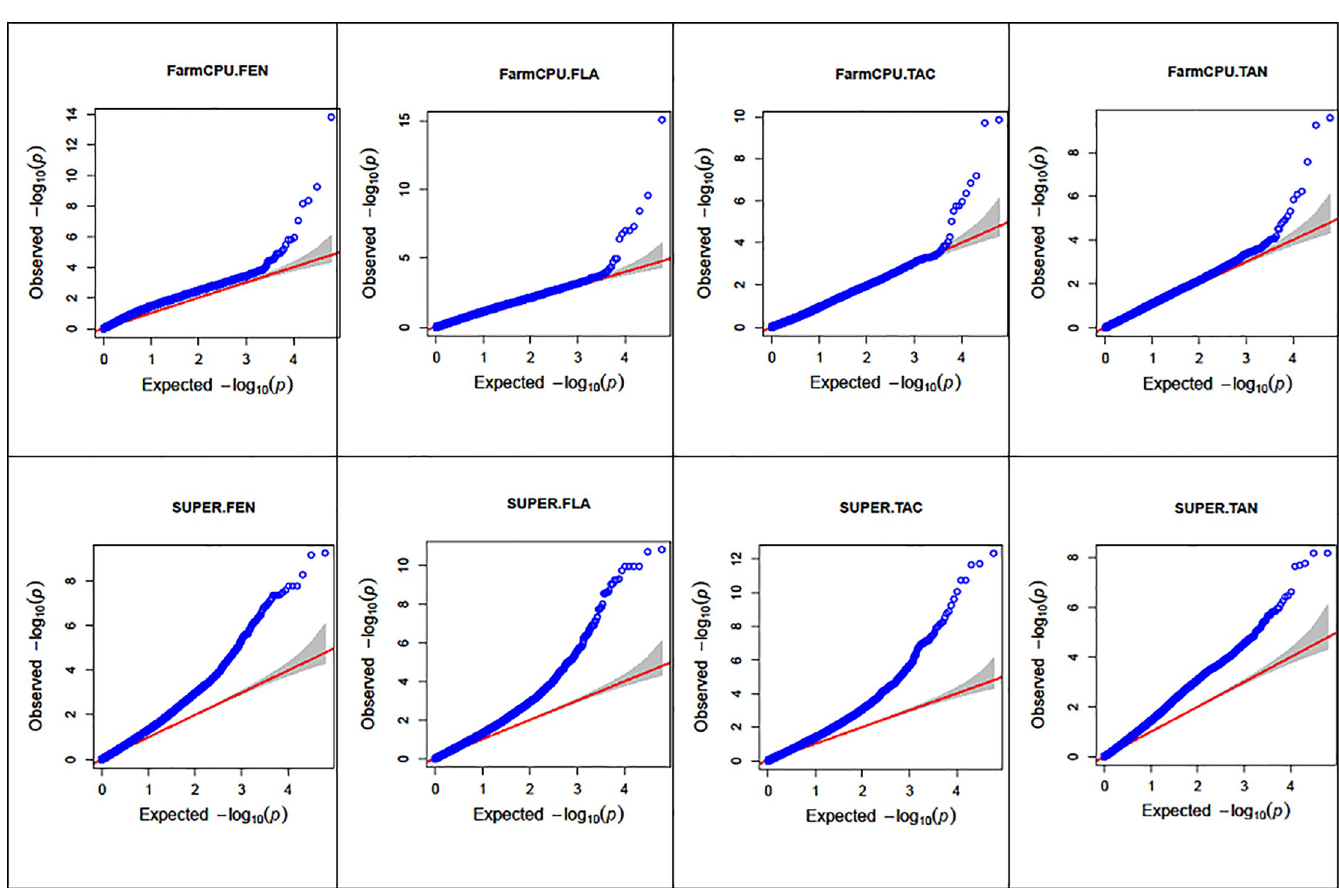
Fig 7. Quantile-Quantile (QQ) plot of observed against expected probability values (P-values) from the genome-wide association analysis. TAN, TAC, FEN, FLA, respectively, condensed tannins, total antioxidants, phenols, and flavonoids. Blue circles correspond to the P-values derived from the principal components + kinship model. The red line indicates the expected P-value distribution under the assumption (null hypothesis) that the P-values follow a uniform [0,1] distribution. The dotted lines show the 95% confidence interval for the QQ-plot under the null hypothesis of no association between the SNP and the trait. -log 10 (P) negative base 10 logarithm of the P-values (probability of type-I error made in GWAS hypotheses testing). Refer to text for the description of the SUPER and FarmCPU